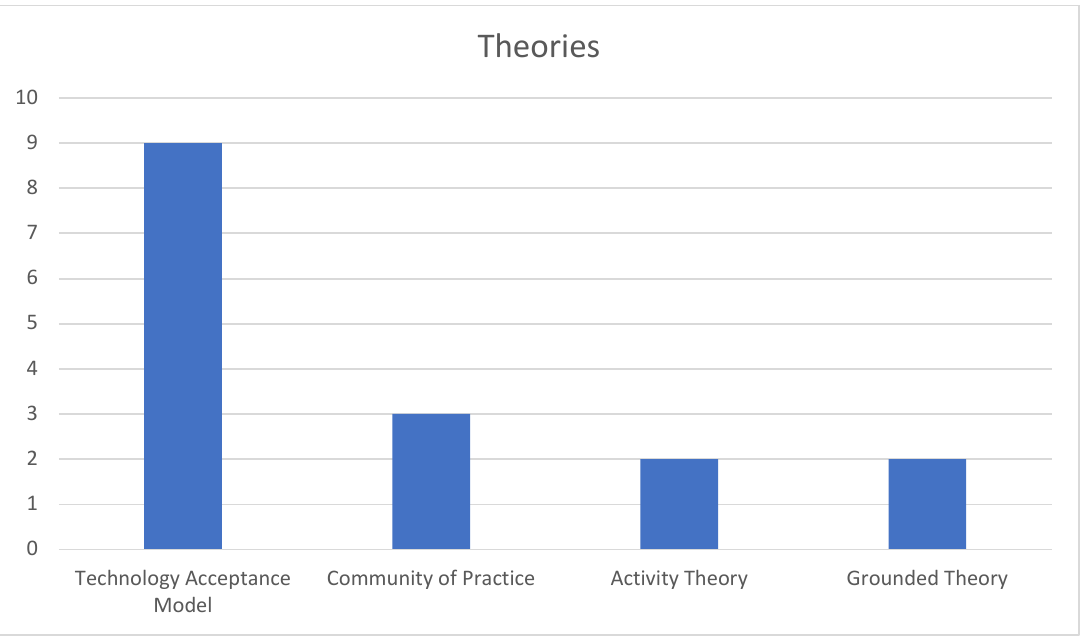
Theories Used to Analyse Articles From the